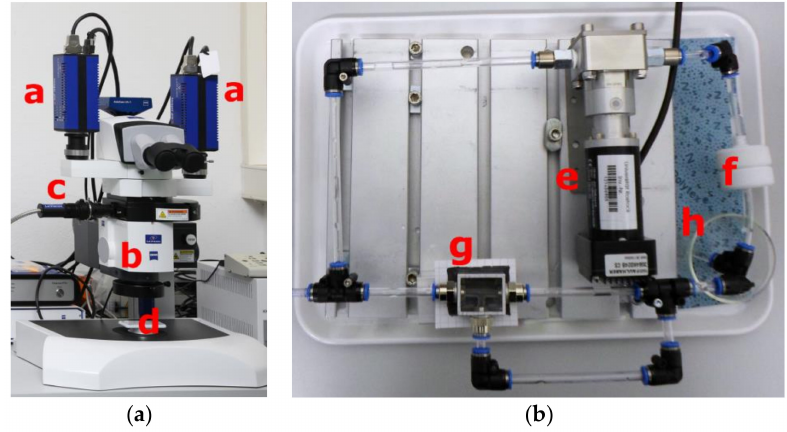
Figure 2. Left: (a) Micro Stereo particle image velocimetry (PIV) system consisting of double-frame cameras; (b) stereo microscope; (c) laser fiber and (d) measurement setup; Right: Measurement setup